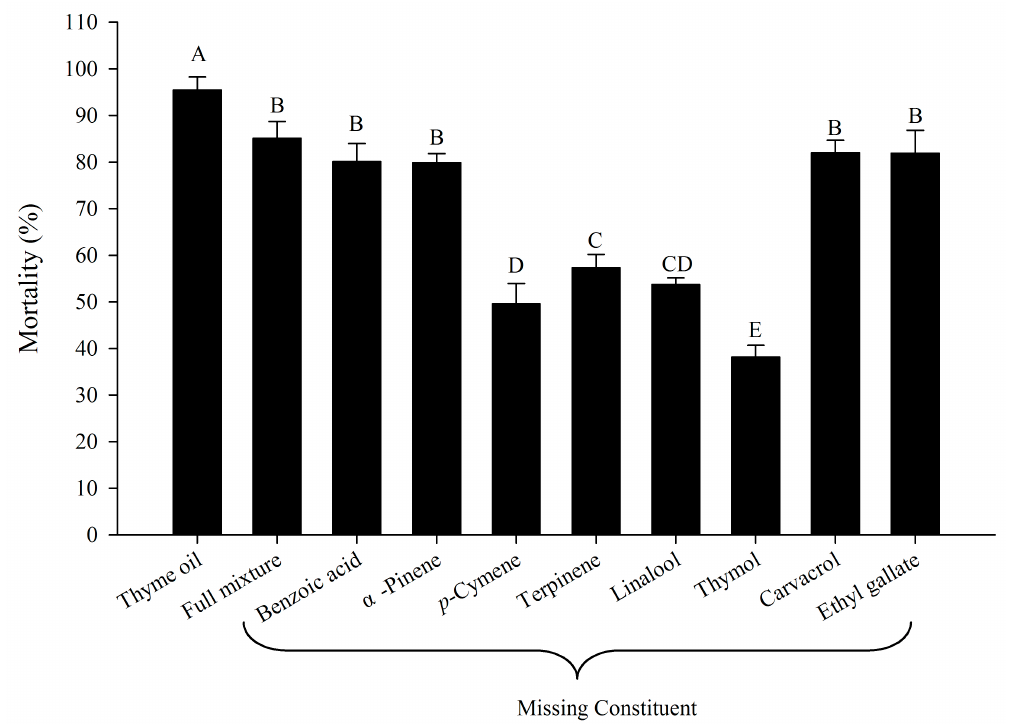
Figure 1. Mortality caused by natural thyme oil, full mixture, and blends of constituents of thyme oil when applied at the concentration at which the natural thyme oil causes 95% mortality. “Full mixture” indicates a blend of eight major constituents (proportion > 1%), whereas all others indicate full mixture missing the constituent noted. Error bars represent the standard error of the mean of four replicates (40 mites per replicate). Means followed by different letters are significantly different from each other (Tukey’s test, p < 0.05).